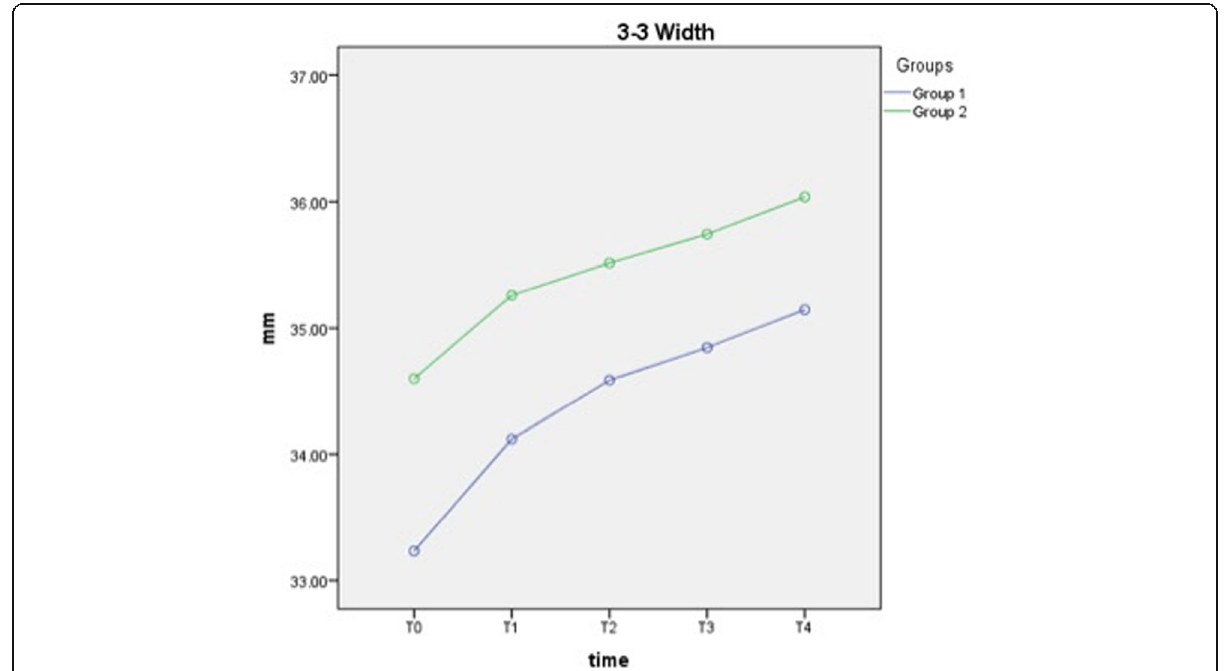
Fig. 4 Change of intercanine width measurements over time